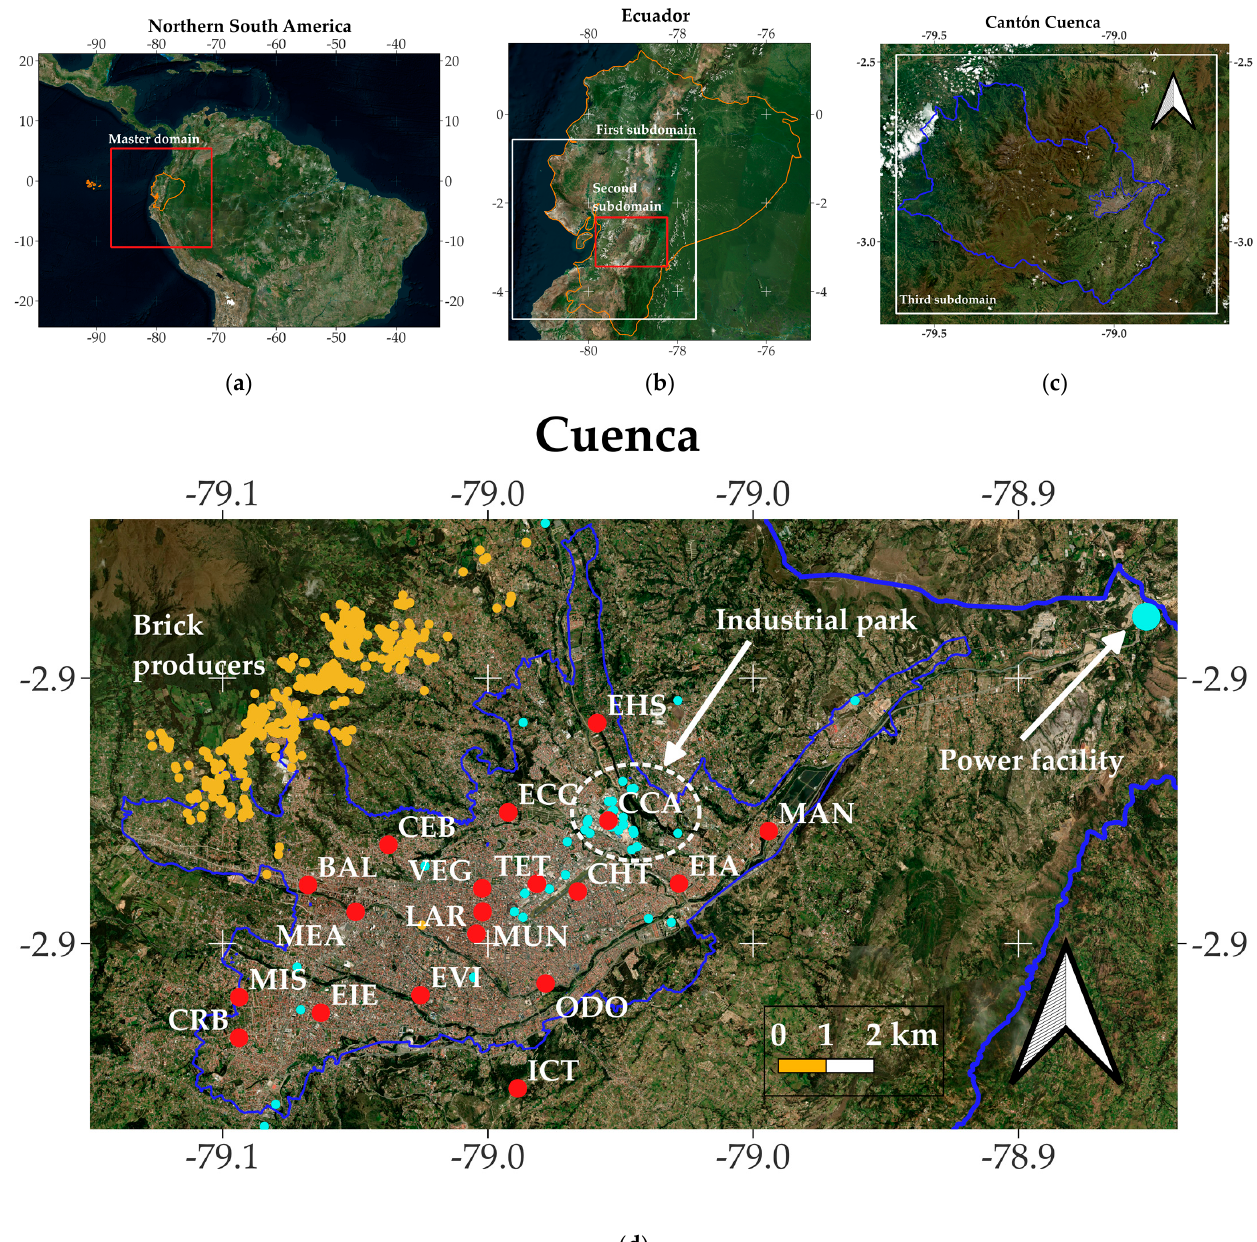
Figure 1. Location of: ( a ) Ecuador and ( b , c ) Cantón Cuenca. ( d ) The urban area of Cuenca (blue border) and the air quality network from Cuenca (red dots). Nomenclature of stations: MUN, Municipio; MAN, Machángara; CEB, Cebollar; BCB, and Bomberos; ICT, Ictocruz; CRB, and Colegio Rafael Borja; MIS, Misicata; EIE, Escuela Ignacio Escandón; EVI, and Escuela Velasco Ibarra; ODO, Facultad de Odontología; LAR, Calle Larga; BAL, Balzay; MEA, and Mercado El Arenal; CHT, Colegio Herlinda Toral; VEG, Vega Muñoz; TET, and Terminal Terrestre; EIA, Escuela Ignacio Andrade; ECC, Escuela Carlos Crespi; CCA, and Colegio Carlos Arízaga; and EHS, Escuela Héctor Sempértegui. Yellow dots indicate the artisanal brick producers. Cyan dots indicate industries.